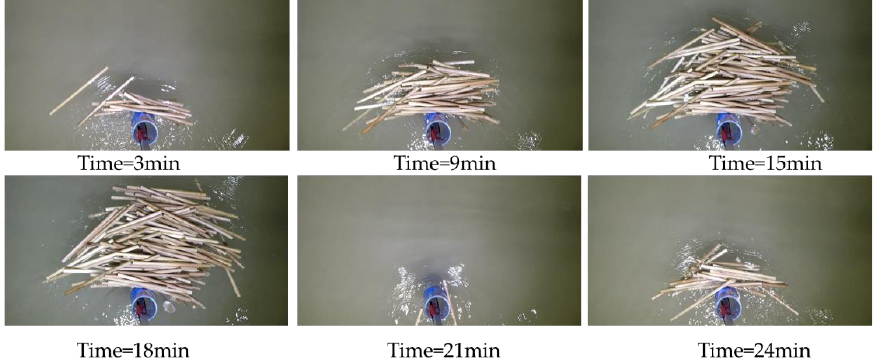
Figure 5. A typical case for the growth, failure, and rebirth of dynamic debris jam (test 1).